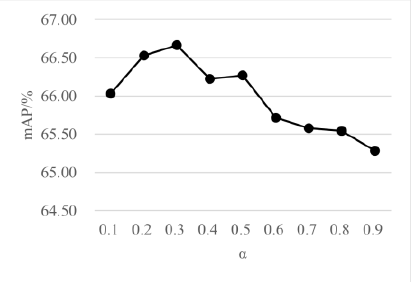
Figure 10. Comparison of P-FPS and FPS on recalling GT points: ( a ) P-FPS (recall 1507 points); ( b ) FPS (recall 575 points).